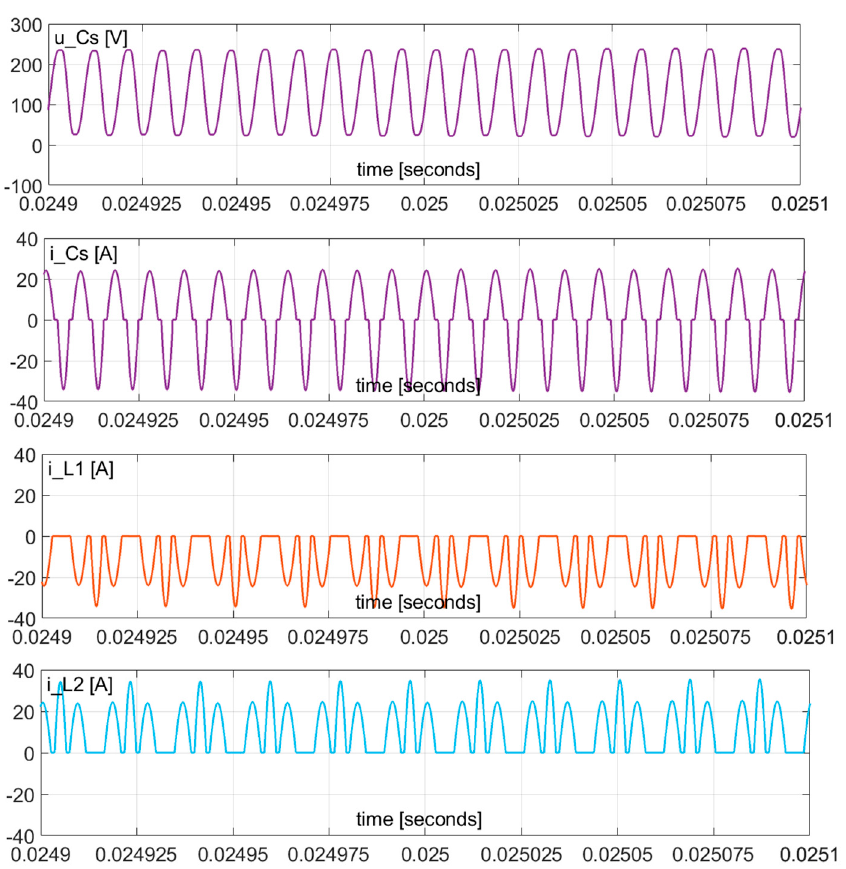
Figure 10. Steady state waveforms of the AIVB operating with constant frequency. Voltage and cur-